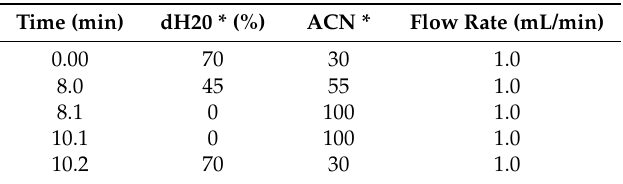
(Table 3). The sodium adduct of verapamil (455.5 m / z ) was analyzed by mass spectrometry (MS) using electrospray ionization (ESI) in positive ion mode. The ESI–MS was optimized with N 2 gas at 150 and 4500 volts, respectively. The nebulizer pressure was set at 40 psig. Table 3. LC-MS Gradient Conditions for Elution of Verapamil.